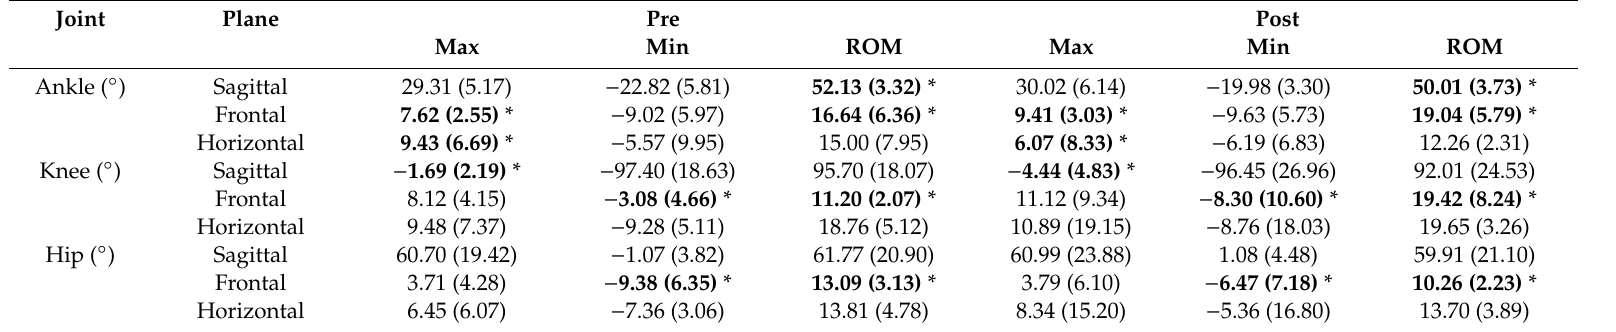
Table 2. Peak joint angles and range of motion (ROM) of pre-fatigue and post-fatigue during the push-o ff phase.